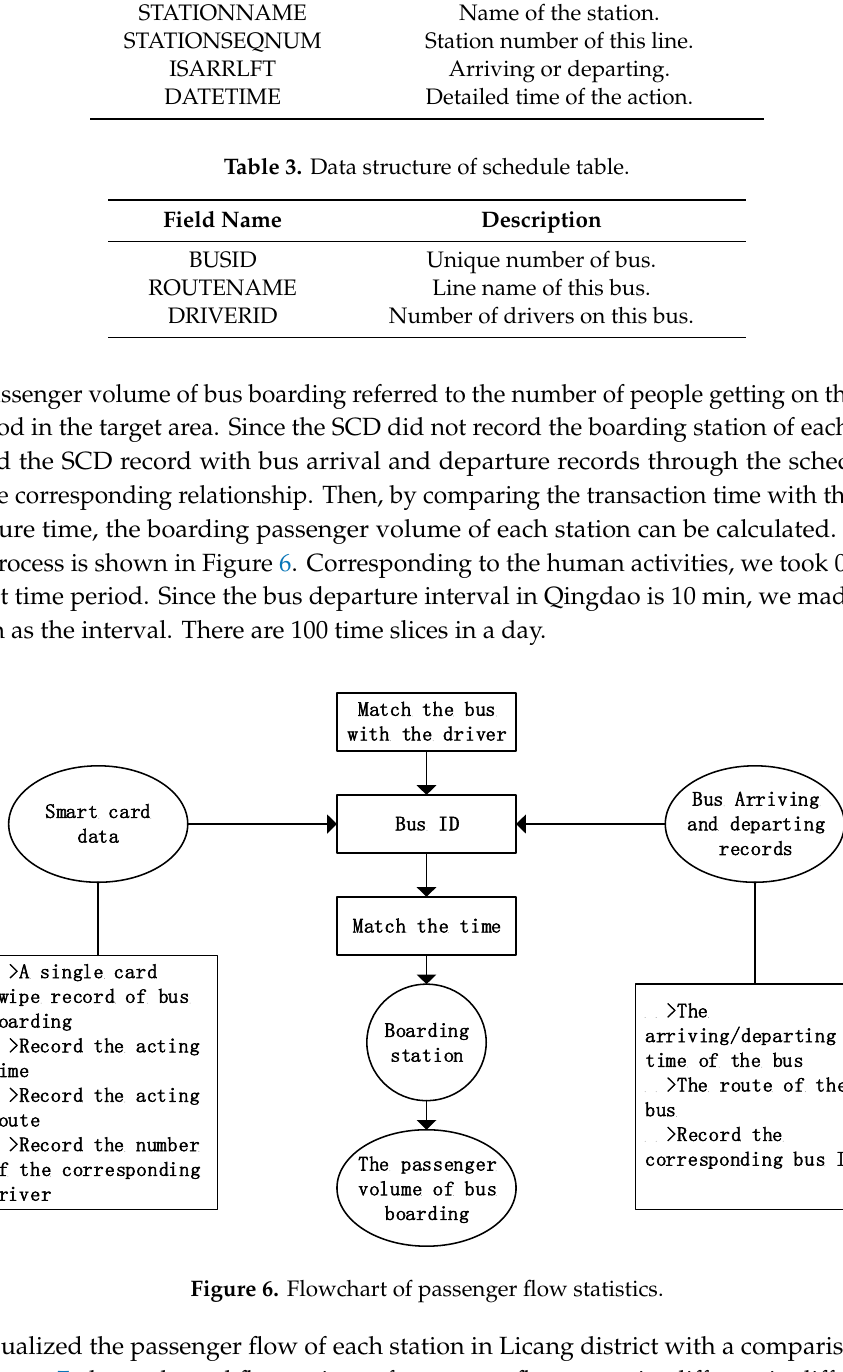
Figure 7. A comparison diagram of passenger flow distribution at key regional stations. Taking "Licun Park" as an example, we drew the time series plot of passenger flow for the first week of March 2016. From Figure 8, we can see that there is a difference between working days and non-working days in terms of passenger flow. Figure 8. Time series plot of passenger flow, 7‒13 March 2016, Licun Park.